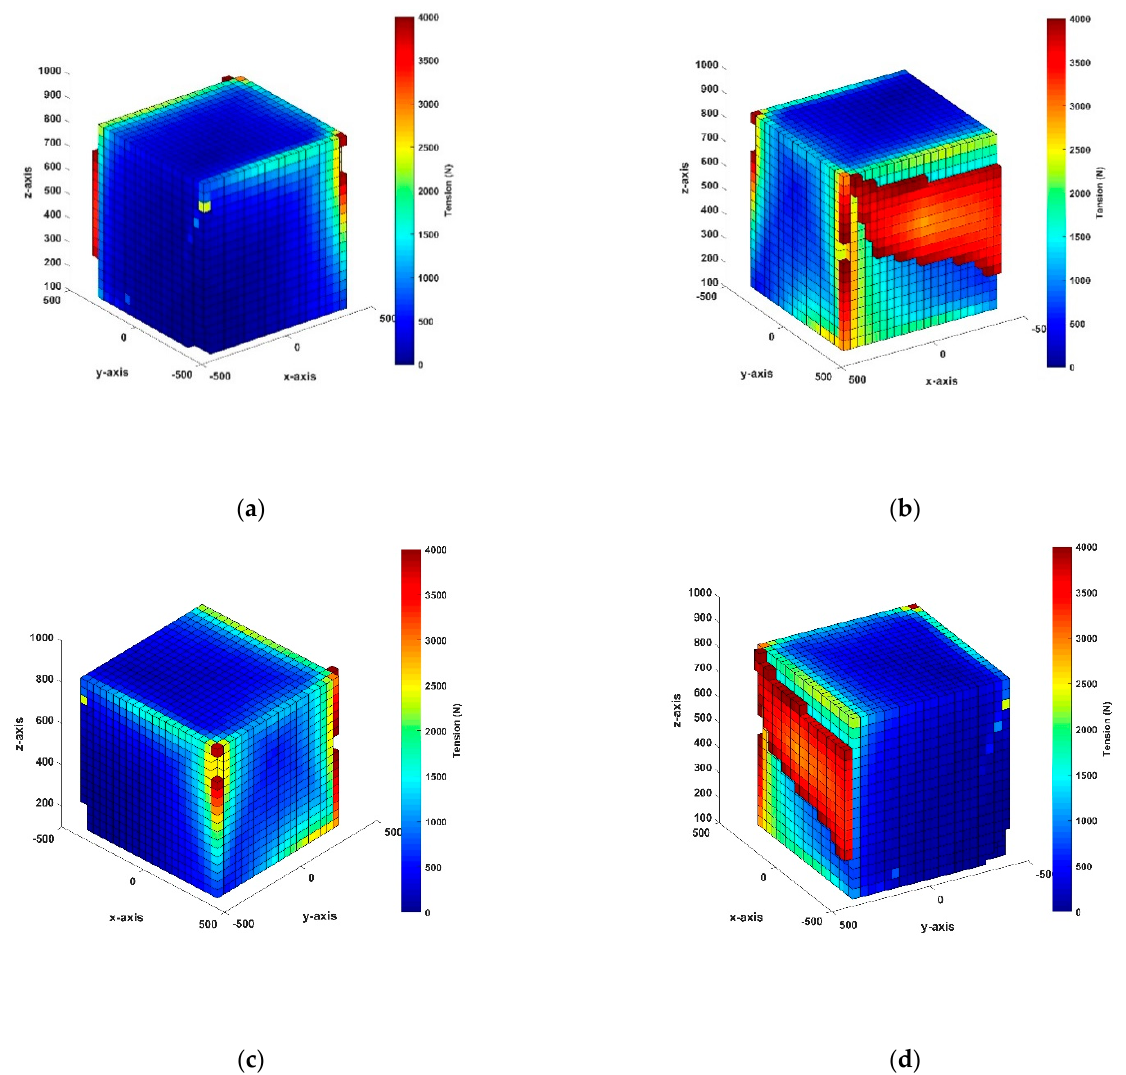
Figure 10. Overall workspace simulation at the acceleration of 100 m/s 2 : ( a ) front plane of the X –axis; ( b ) back plane of the X –axis; ( c ) front plane of the Y –axis; ( d ) back plane of the Y –axis.